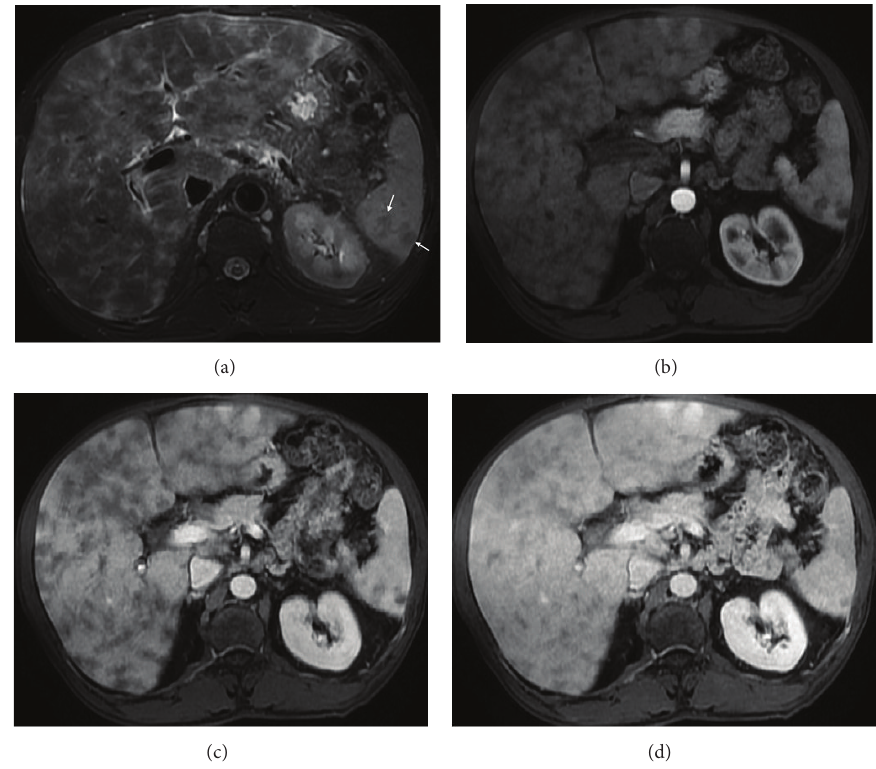
Figure 8: Sarcoidosis. Axial T2wi FSE with fat suppression (a) and postcontrast axial T1wi 3D-GRE with fat suppression in the arterial (b), venous (c) and interstitial phases (d). Low signal intensity nodules are depicted in the spleen on the T2wi sequences (arrows, (a)). The lesions are most conspicuous on fat-suppressed T2wi or early phase (b) contrast-enhanced images. Note the progressive enhancement of the sarcoid lesions on venous (c) and delayed images